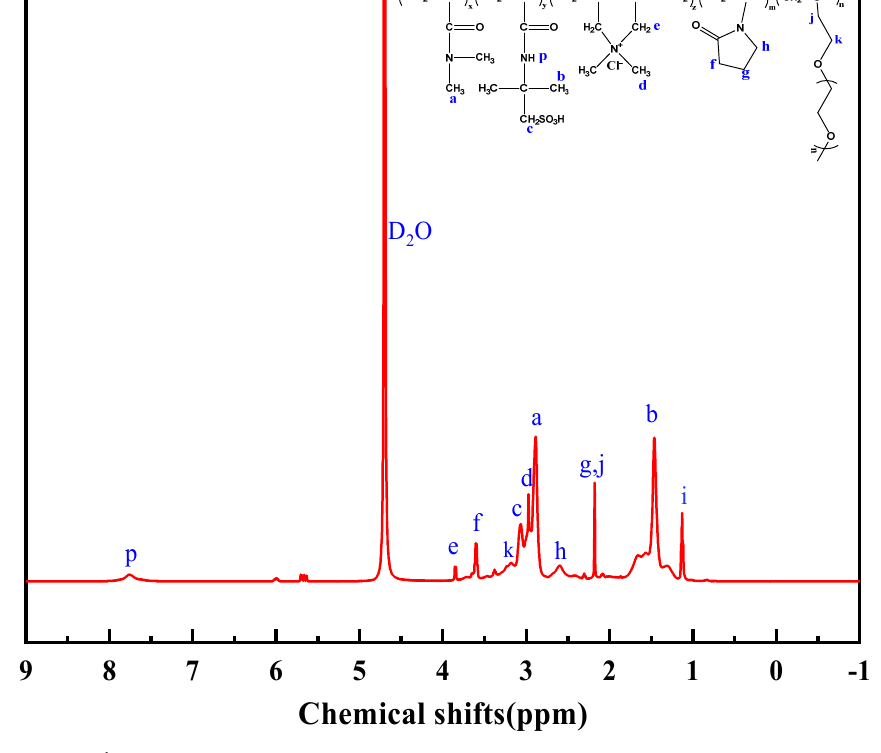
1 H NMR spectrum of DNDAP. Figure 2.